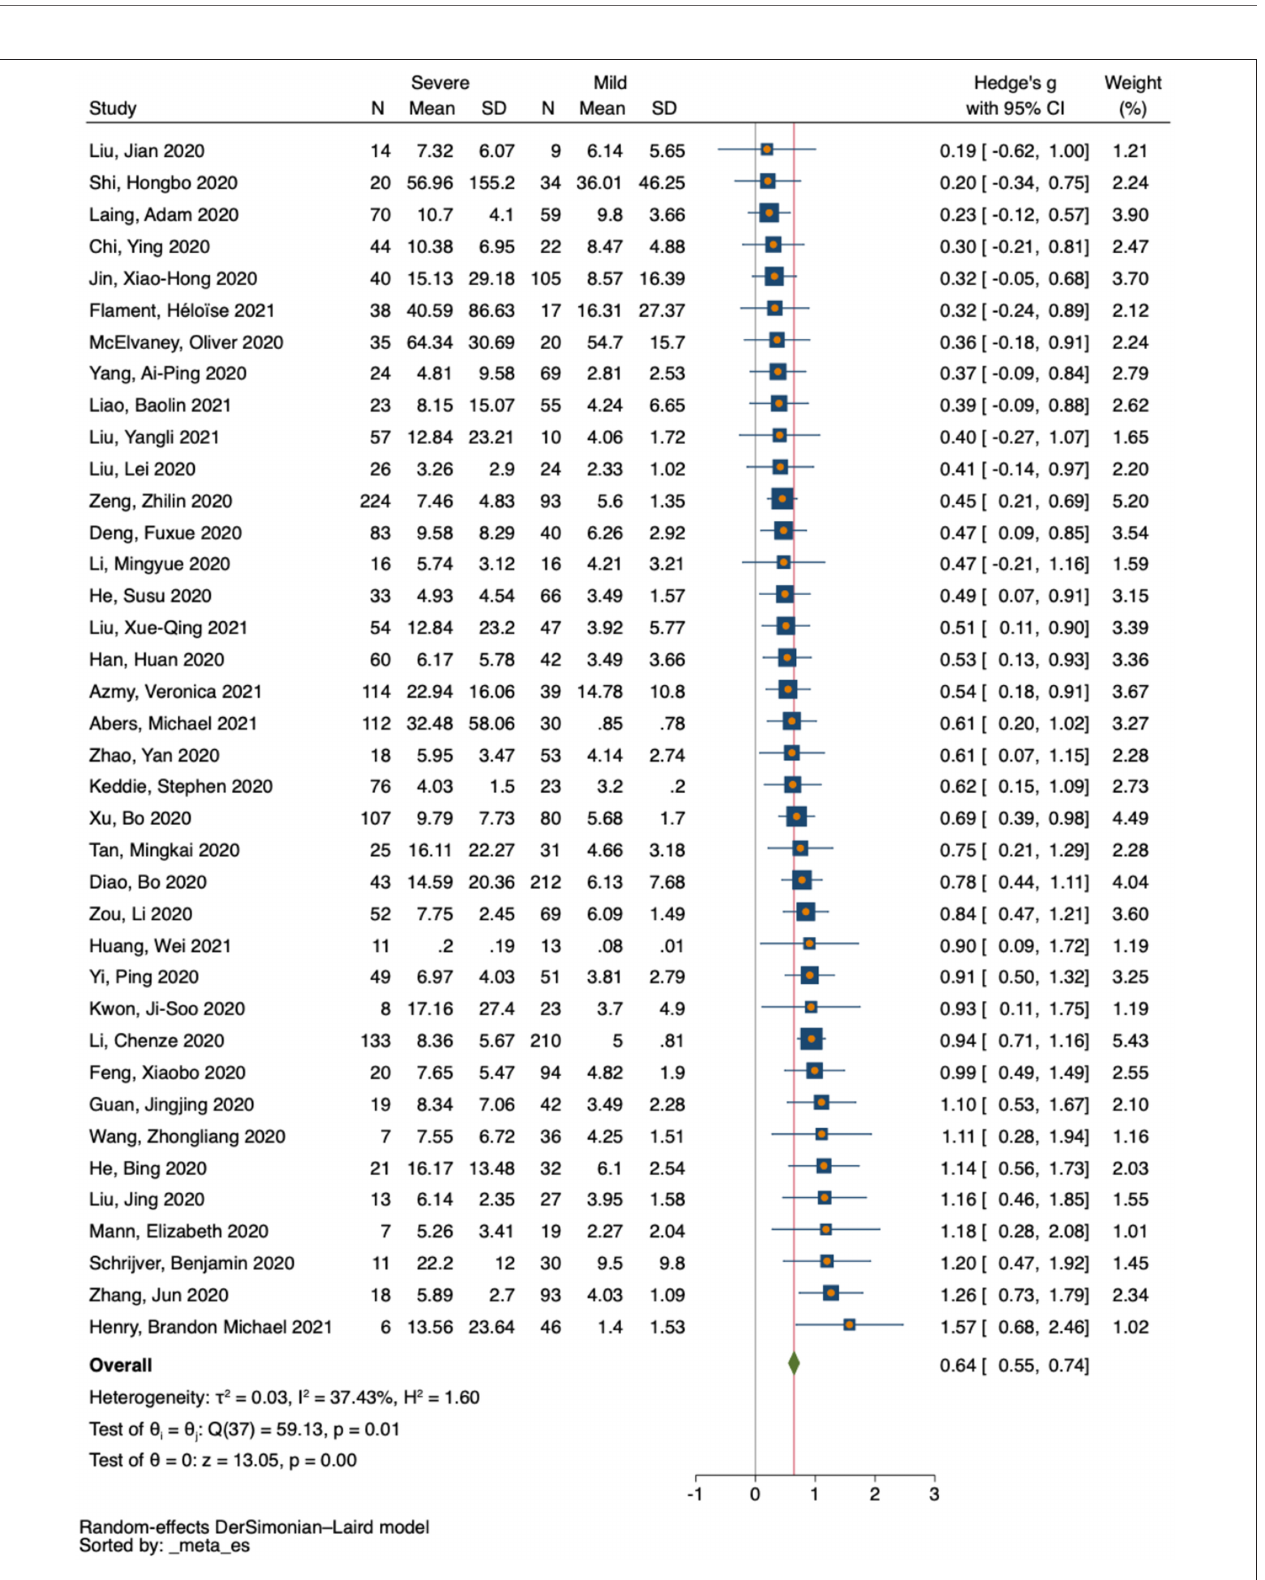
FIGURE 4 | Forest plot of IL-10 in COVID-19 severity studies. The no-effect line is represented at the value of zero. The diamond symbol represents estimated combined effect size.